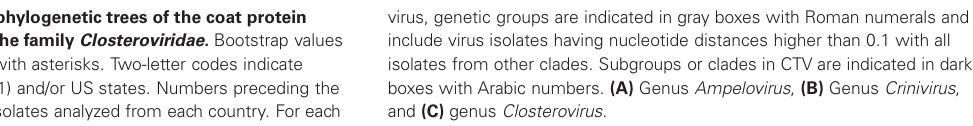
FIGURE 1 | Neighbor-joining phylogenetic trees of the coat protein genes of different viruses of the family Closteroviridae . Bootstrap values higher than 0.75 are indicated with asterisks. Two-letter codes indicate countries (defined in ISO 3166-1) and/or US states. Numbers preceding the codes indicate the number of isolates analyzed from each country. For each